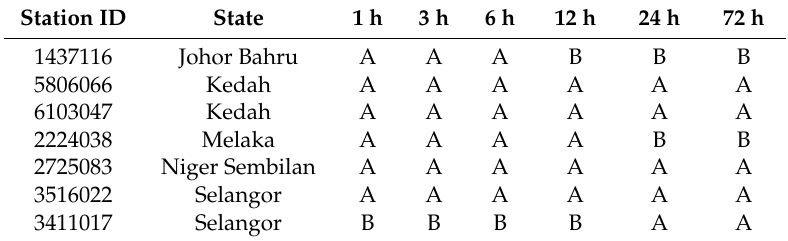
Table 4. Best PDF and parameter estimation methods over selected